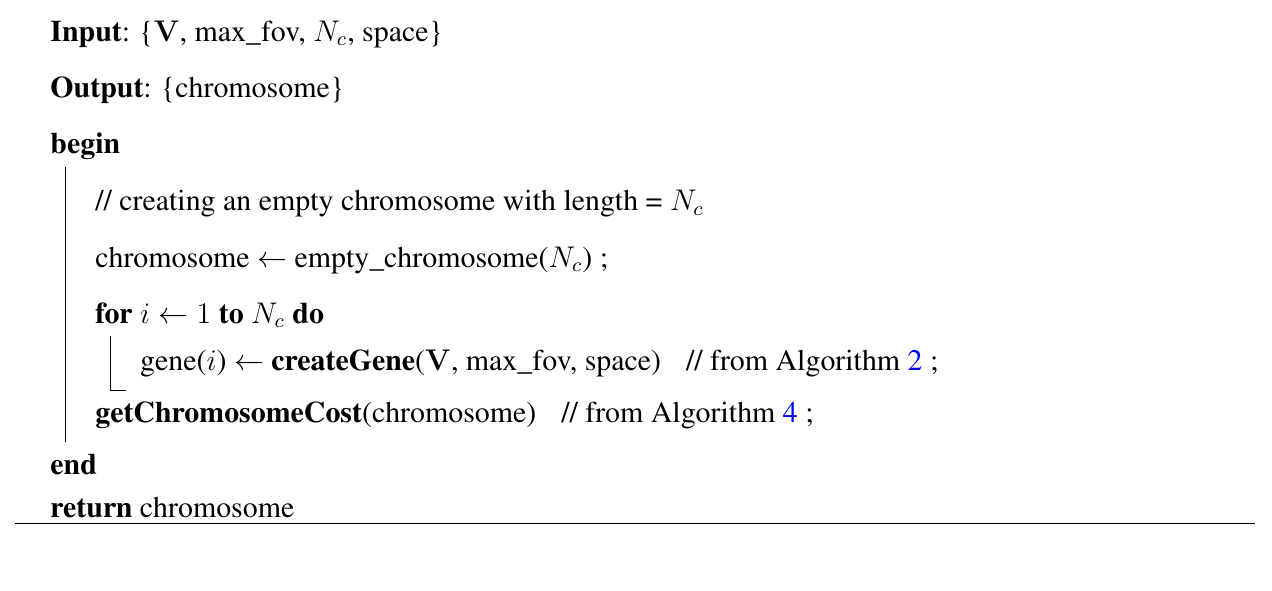
genes and returns it (using Algorithm 2). c